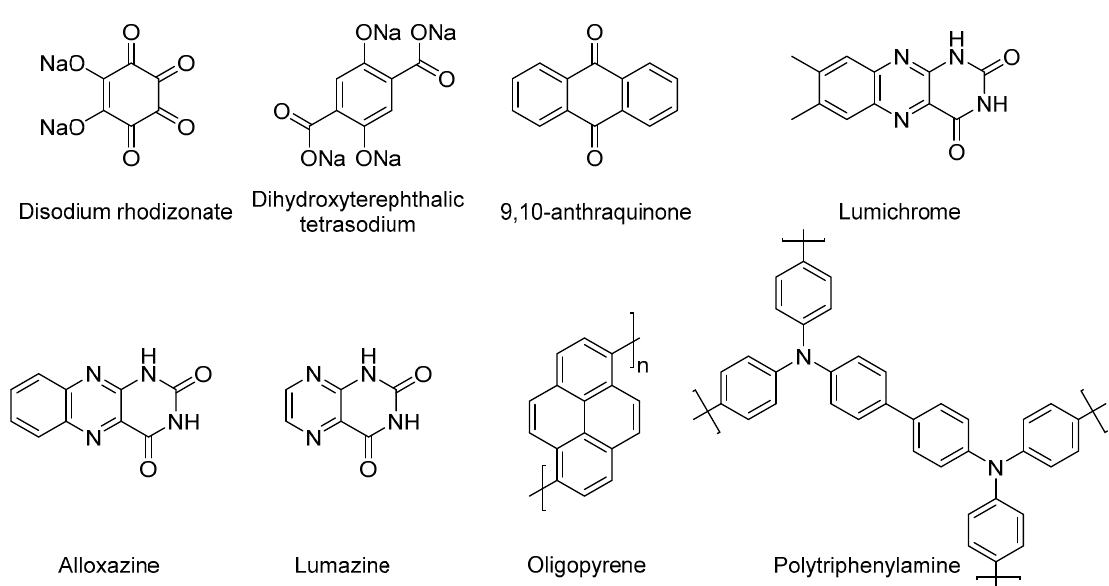
Figure 4. Eight molecules used as organic cathodes in Na-ion batteries. (Adapted from reference [69] with permission).